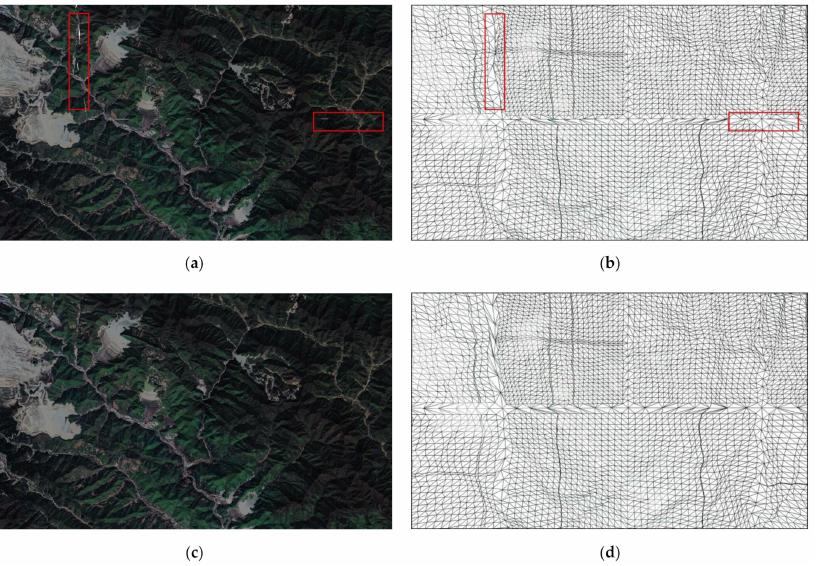
Figure 12. A terrain with cracks. ( a , b ) show a terrain with cracks. The cracks are marked by red rectangles. ( c , d ) show the result of our crack-free